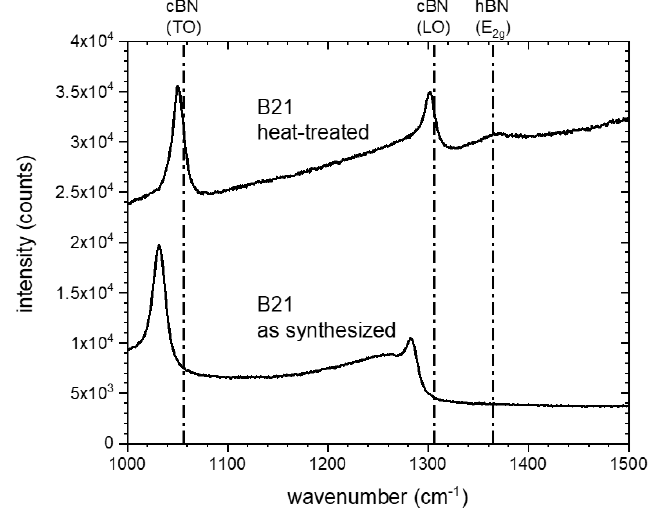
Figure 11. Raman spectra of the under argon tempered cBN powder B21 compared to the initial powder B21.